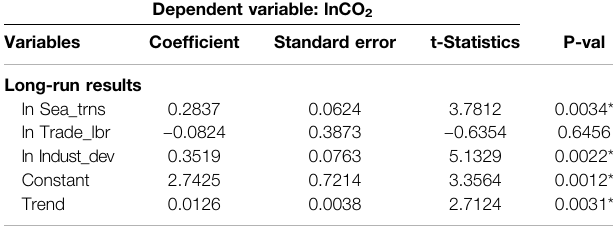
TABLE 4 | Long-term ARDL estimation results of China.